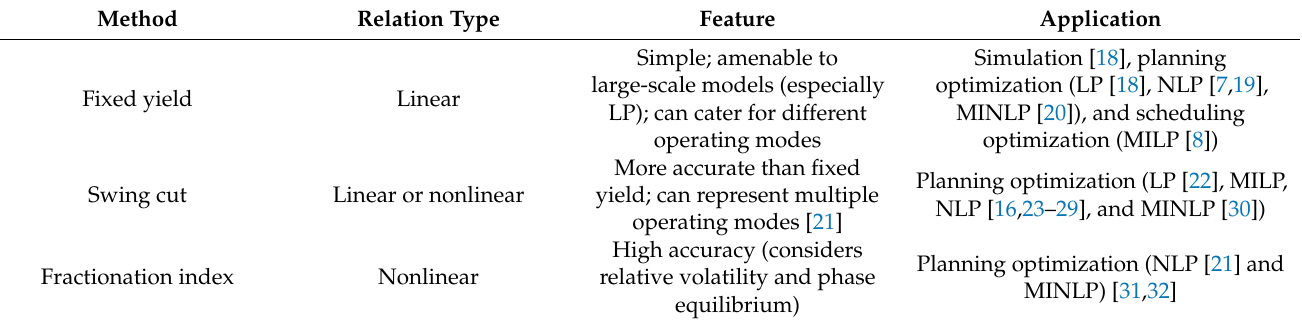
Figure 1. Modeling methods for petroleum refinery distillation cutpoints (mainly for CDUs). Table 1. Methods to model the refinery distillation yields of crude oils.